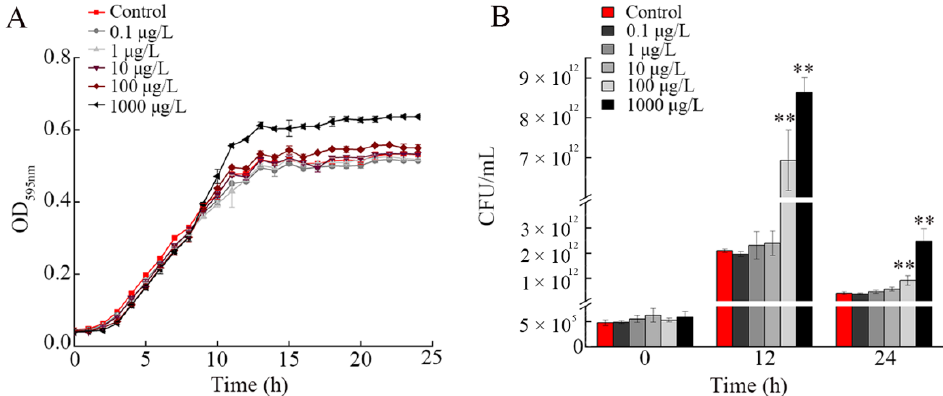
Figure 3. Effect of nanopolystyrene particle (NP) exposure on growth of A. johnsonii AC15. ( A ) Growth curves of A. johnsonii AC15 after exposure to NPs at different concentrations. ( B ) Effect of NP exposure on colony-forming unit (CFU) of A. johnsonii AC15 at different times. ** p < 0.01 vs.